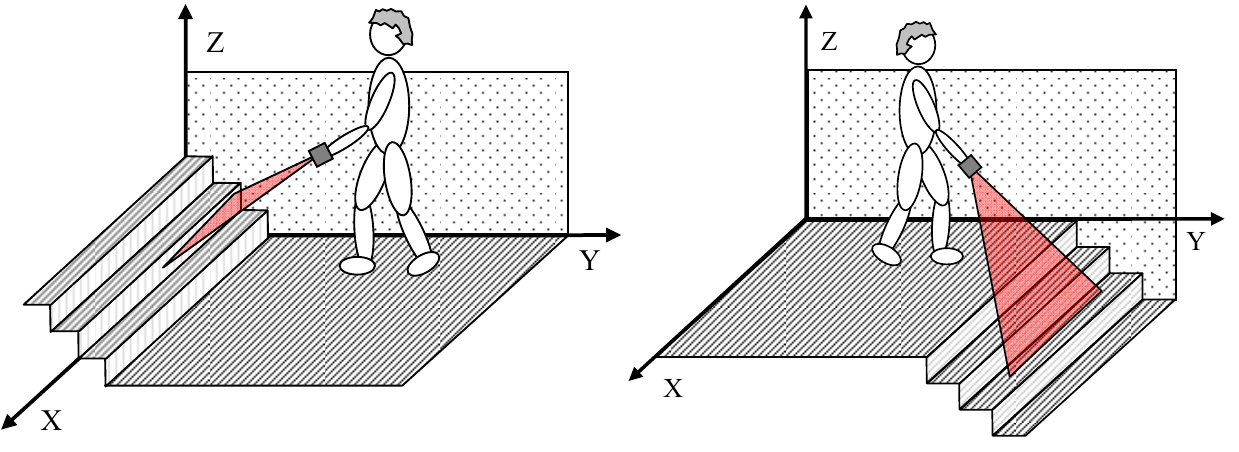
Figure 15. Up (left) and down (right) stairs detected with the electronic white